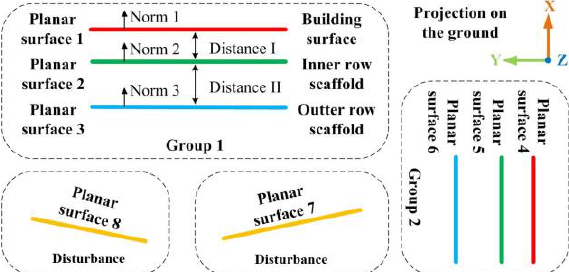
Figure 3. The schematic depiction of the grouping of the planar